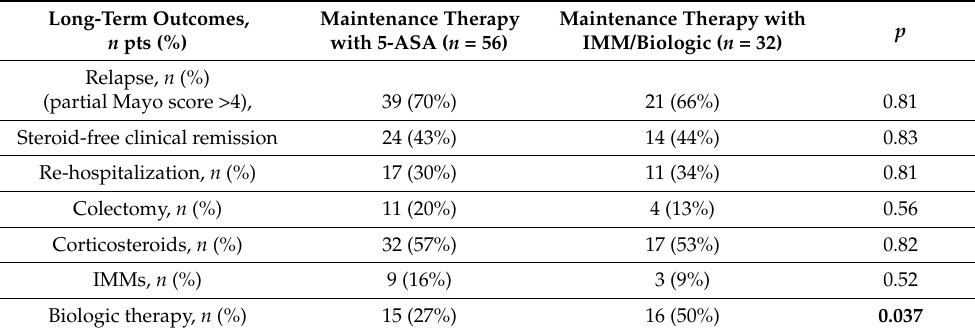
Table 2. Long-term outcomes in 88 patients with severe ulcerative colitis treated with intravenous corticosteroids and different maintenance therapy. 5-ASA = 5-aminosalycilic acid; IMM = immuno- suppressor. Significant value is in bold.